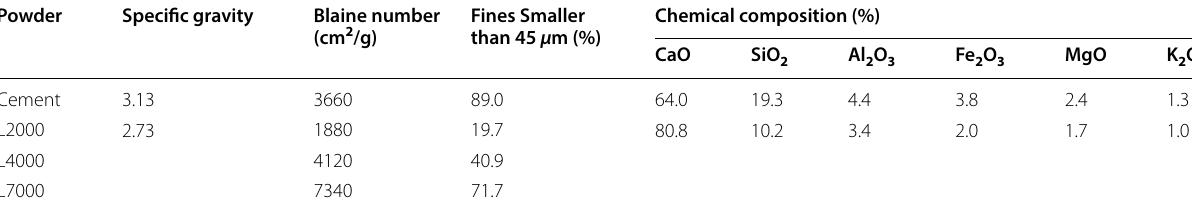
Table 2 Physical and chemical properties of the powders.